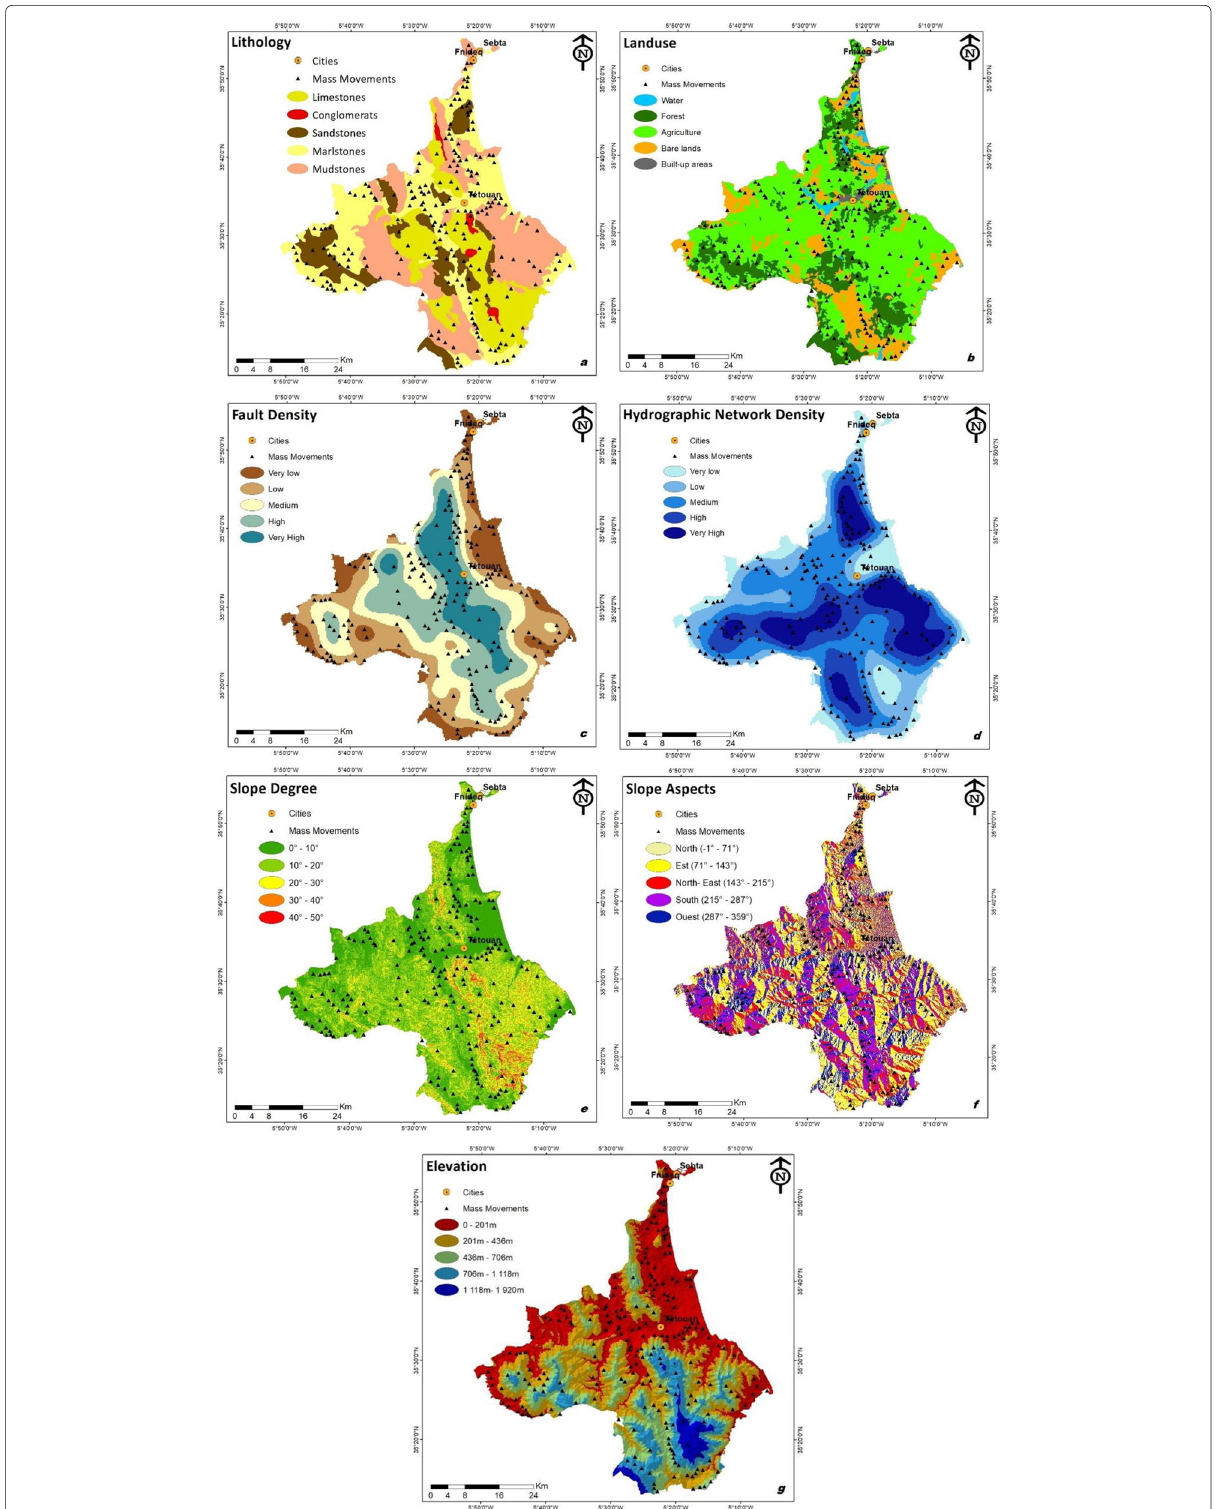
Fig. 6 Seven digital thematic maps of the main selected predisposition parameters of Tétouan